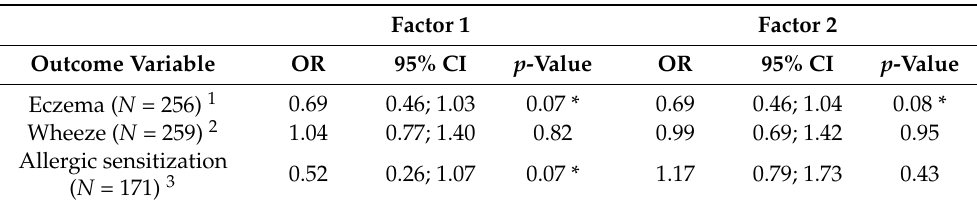
Table 3. Results of the multiple logistic regression analyses to determine relations between the factors and allergic outcomes. Factor 1 Factor 2 Outcome Variable OR 95% CI p -Value OR 95% CI p -Value Eczema ( N = 256) 1 0.69 0.46; 1.03 0.07 * 0.69 0.46; 1.04 0.08 * Wheeze ( N = 259) 2 1.04 0.77; 1.40 0.82 0.99 0.69; 1.42 0.95 Allergic sensitization 0.52 0.26; 1.07 0.07 * 1.17 0.79; 1.73 ( N = 171) 3